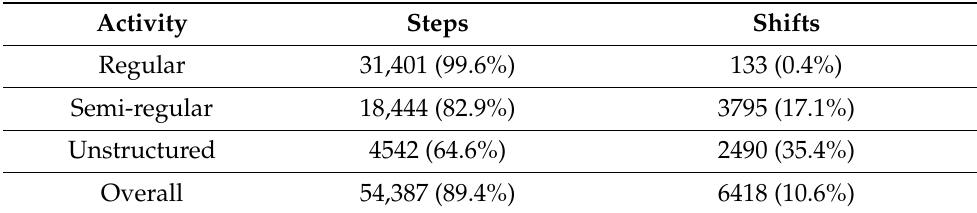
Table 5. Total steps and shifts manually recorded through each of the three activities across all 30